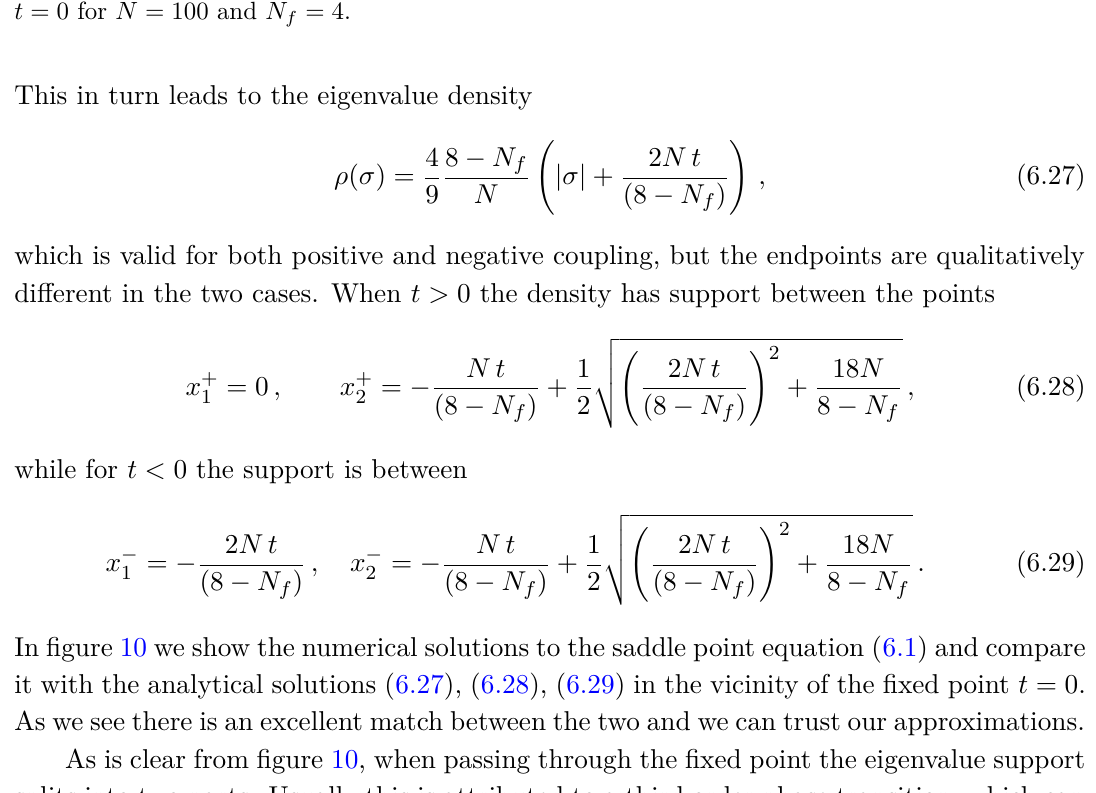
Figure 10 . Comparison of the analytical and numerical solutions in the vicinity of the fixed point t = 0 for N = 100 and N f = 4